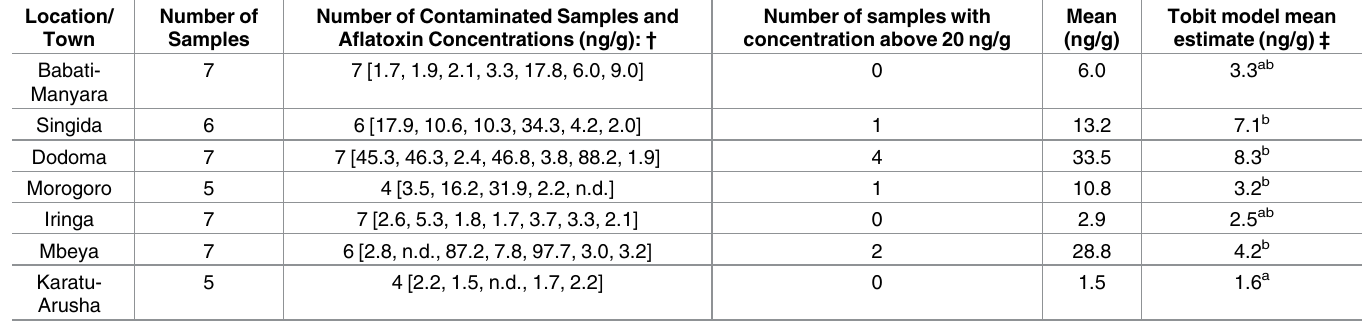
Table 3. Aflatoxin concentrations in sunflower seed cakescollected from micro- and small-scale sunflower oil processors in Tanzania in the sun- flower-harvesting season of 2014. Location/